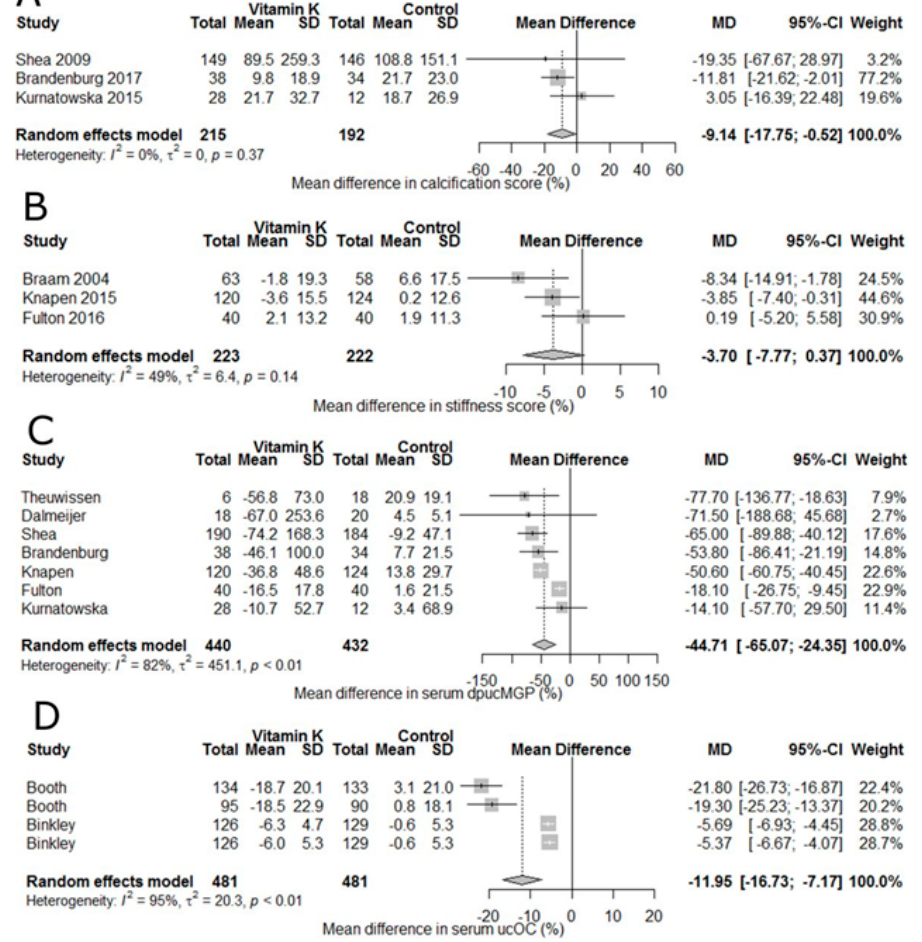
Figure 5 . Forest plots showing the effect of vitamin K supplementation . ( A ) % change in vascular calcification. ( B ) Vascular stiffness. ( C ) Serum dephospho-uncarboxylated matrix Gla protein (dp- u cMGP). ( D ) serum uncarboxylated osteocalcin ( u cOC). Data are presented as mean % difference and 95% CI. From [168].